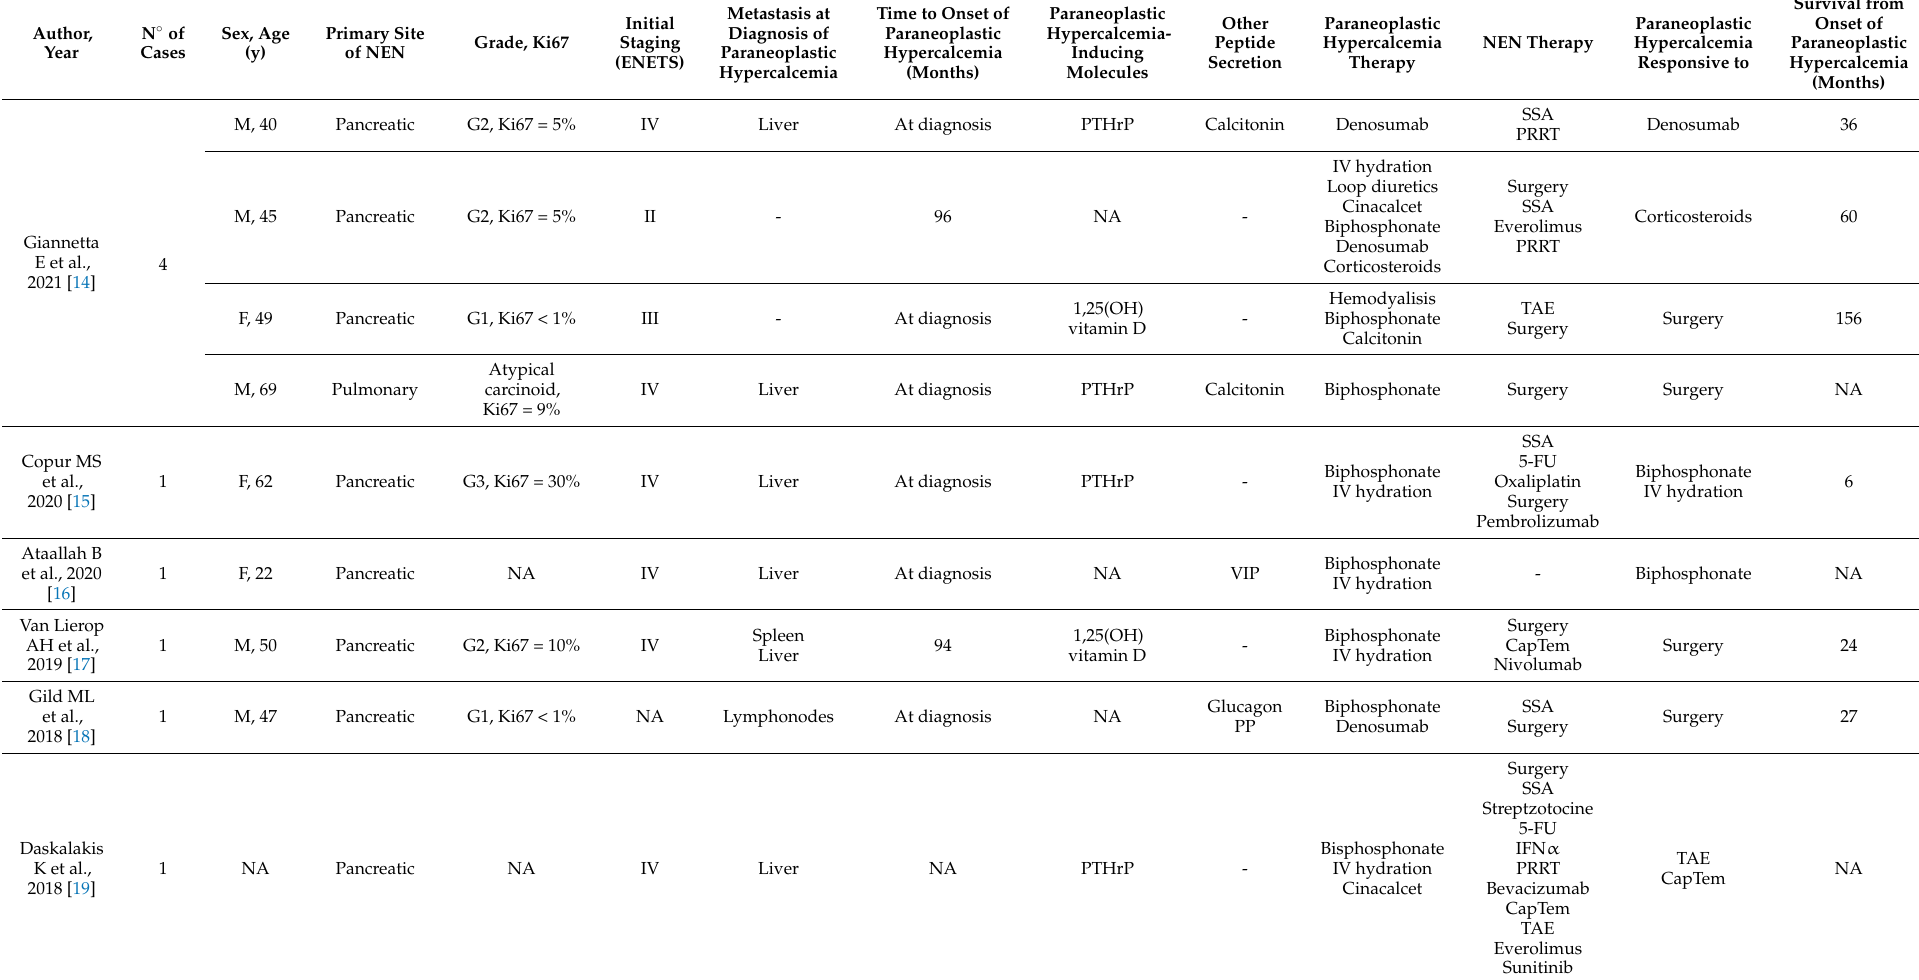
Table 1. Summary of cases of paraneoplastic hypercalcemia in well-differentiated NEN reported in the